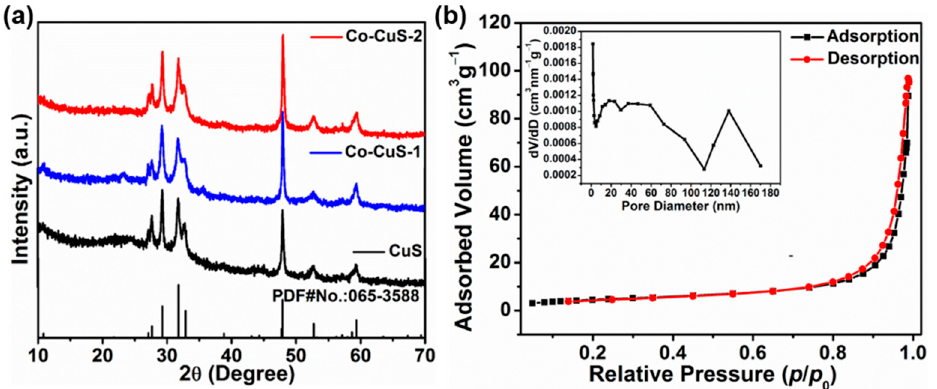
Figure 3. ( a ) XRD patterns of the samples with different proportions; ( b ) N 2 adsorption isotherm and pore distribution of Co-CuS-2.